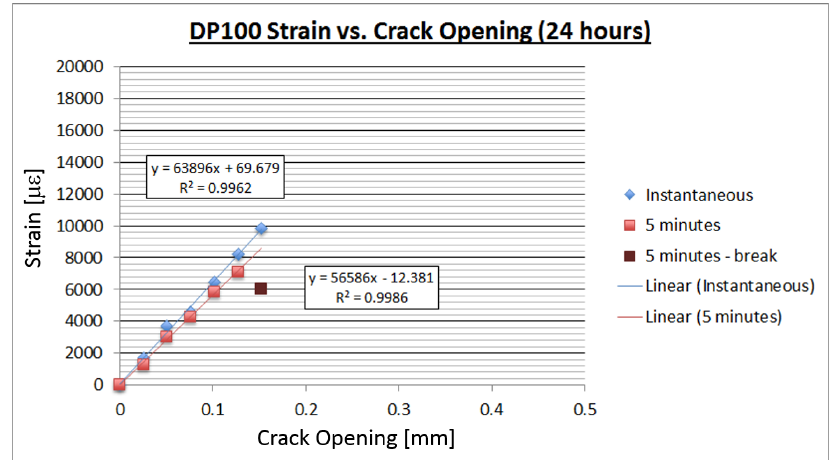
Figure 10. DP100 crack opening vs. strain after 24